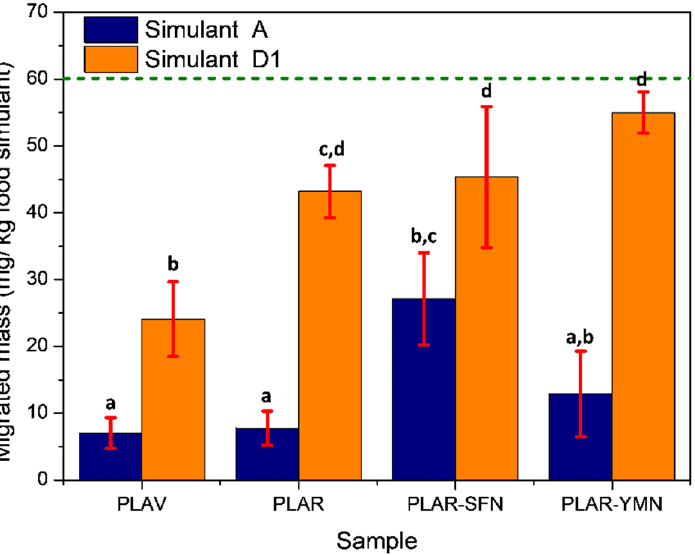
Figure 4. Overall migration of virgin poly(lactic acid) (PLAV) and recycled poly(lactic acid) (PLAR), and nanocomposites to the different food simulants A) (ethanol 10% v / v ) and D1) (ethanol 50% v / v ). The green line indicates the legal overall migration limit (60 mg/kg of food simulant). a–d Different letters indicate statistically significant differences between formulations ( p < 0.05).